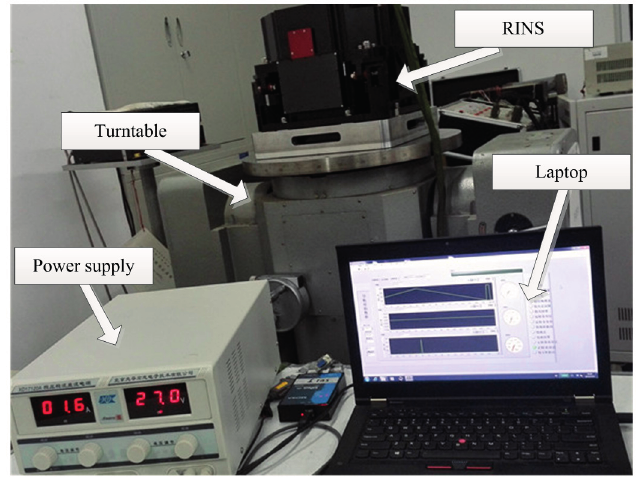
Figure 5. The experimental